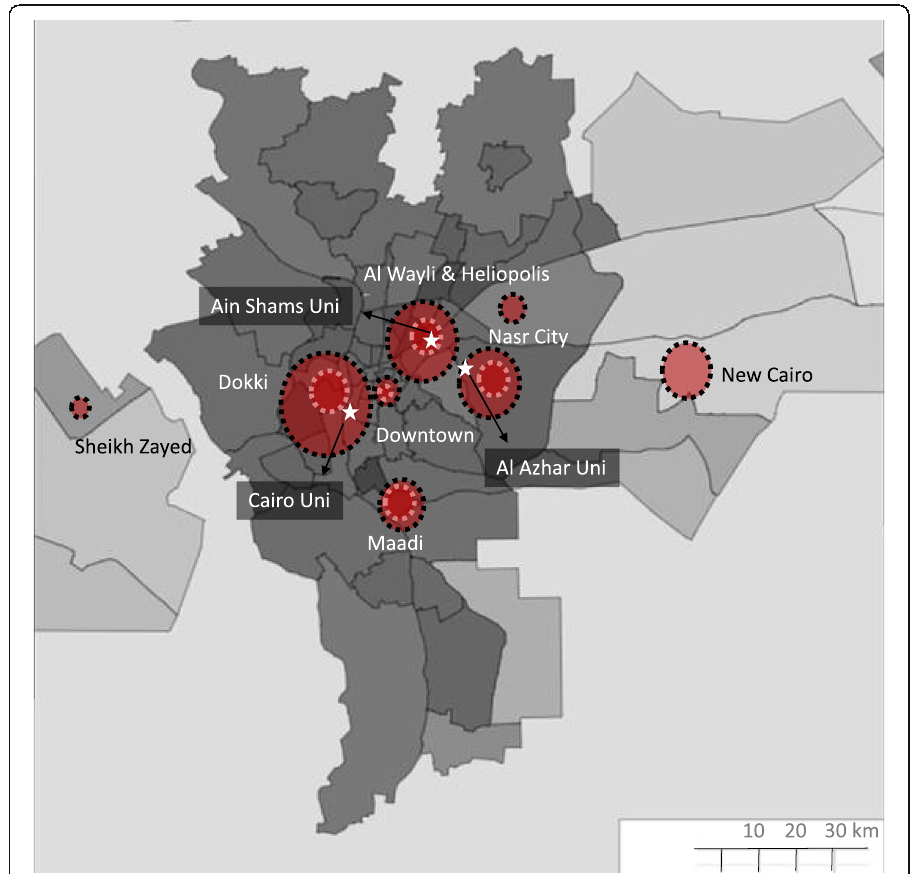
Fig. 3 Mapping representation of co-working spaces in Greater Cairo districts, from 2011 to 2014 (indicated by white borders) and their growth after the emergence of the second wave from 2015 to 2017 (indicated by black borders). Map source https://www.citypopulation.de , elaboration by